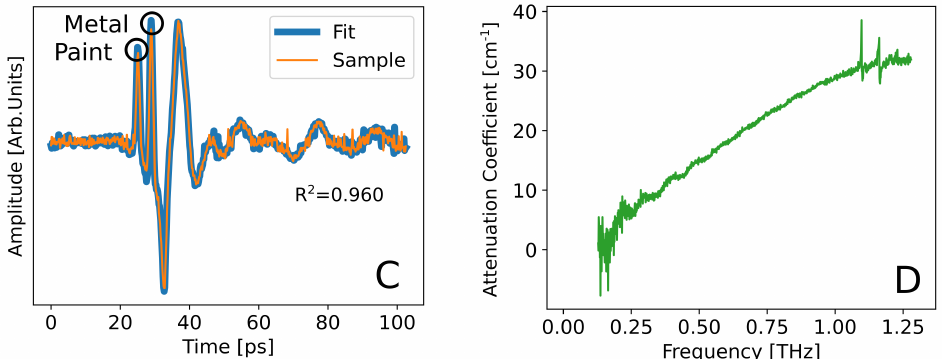
Figure 4. ( A ) Measurement of sample and a reference measurement at θ = 20 and s-polarization. The reference is a measurement of the backside of the paint sample. The circles mark the arrival time of each reflection. ( B ) FFT of ( A ). The shaded blue area contains approx. 90% of the signal power. The vertical blue line represents the maximum power output at 0.1THz. ( C ) Fit using the two measurements from figure ( A ), results in a paint thickness of 232.8µm. ( D ) Attenuation coefficient of silicone in the THz frequency domain, measured in a transmission